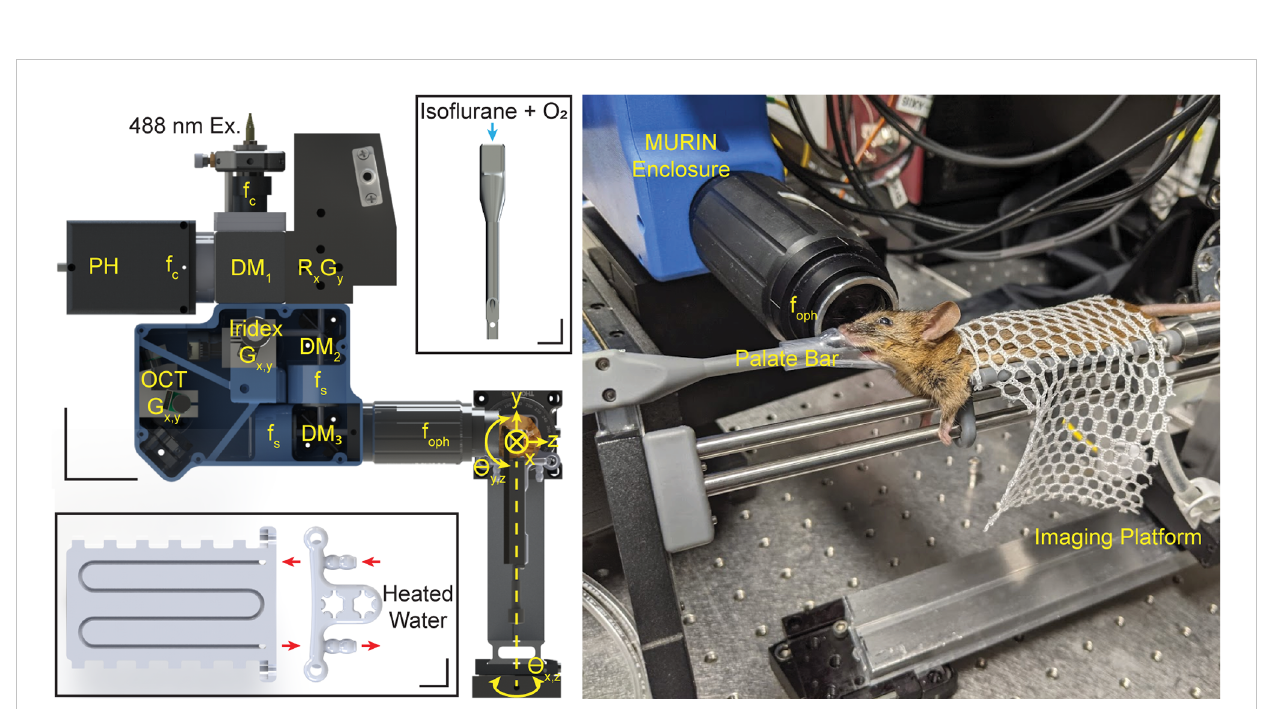
FIGURE 3 Mechanical layout for MURIN showing optics and optomechanics in the custom-designed mechanical enclosure and 5-axis imaging platform. DM: dichroic mirrors; f: collimating, objective, and scan lens; G: galvanometers; R: resonant scanner. Scale bar: 50 mm. Insets show custom-designed palate bar and water-heated imaging bed. Scale bars: 10 mm. Photograph shows animal during an imaging experiment with head positioned using the palate bar with nose cone and the body resting on the imaging bed attached to the 5-axis imaging